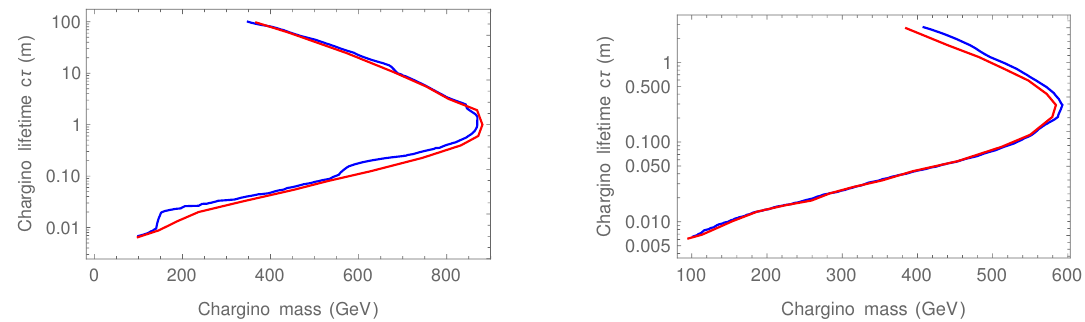
Figure 15. Comparison between the experimental result (red) and our reinterpreted result (blue) for the latest DT searches performed by CMS [67] (left) and ATLAS [65] (right).